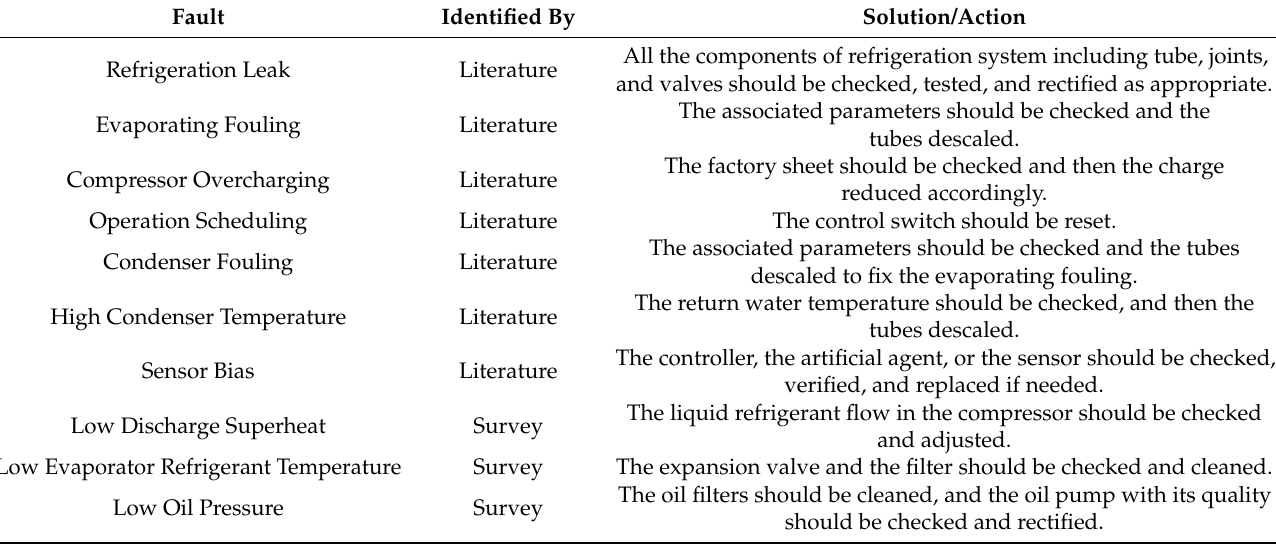
Table 4. Chillers faults and